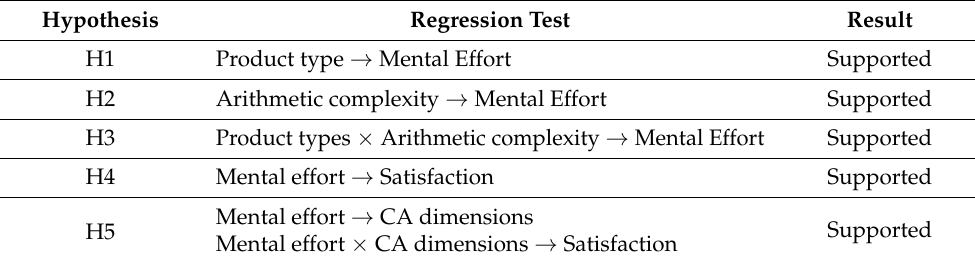
Table 9. Summary of